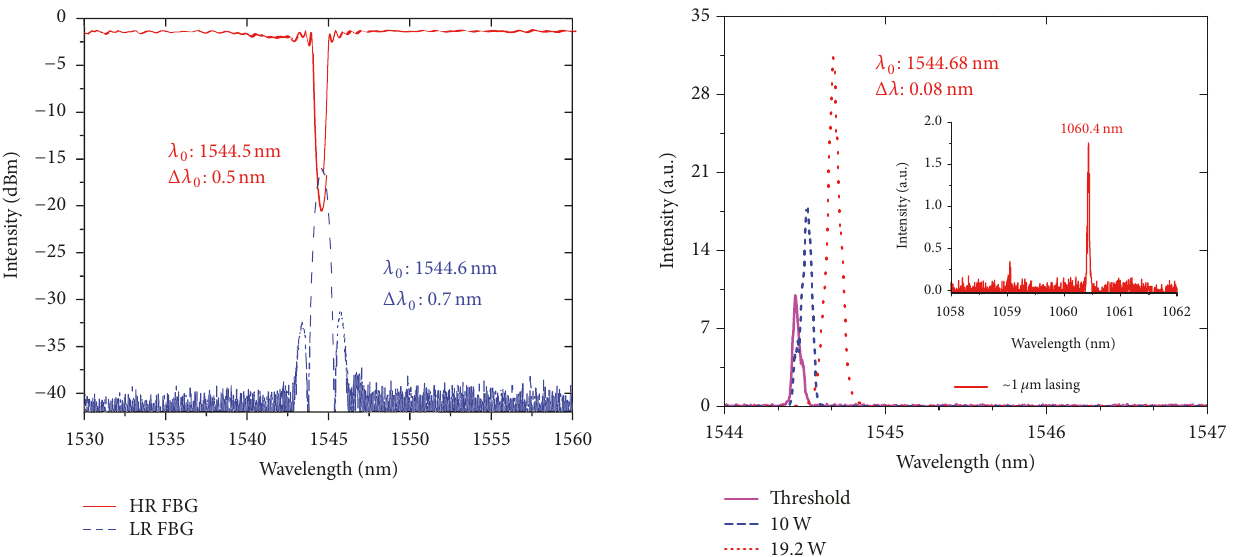
Figure2:Measuredtransmissionspectrumandreflectionspectrum of the high-reflection (HR) FBG (red line) and low-reflection (LR) FBG (blue dash), respectively.